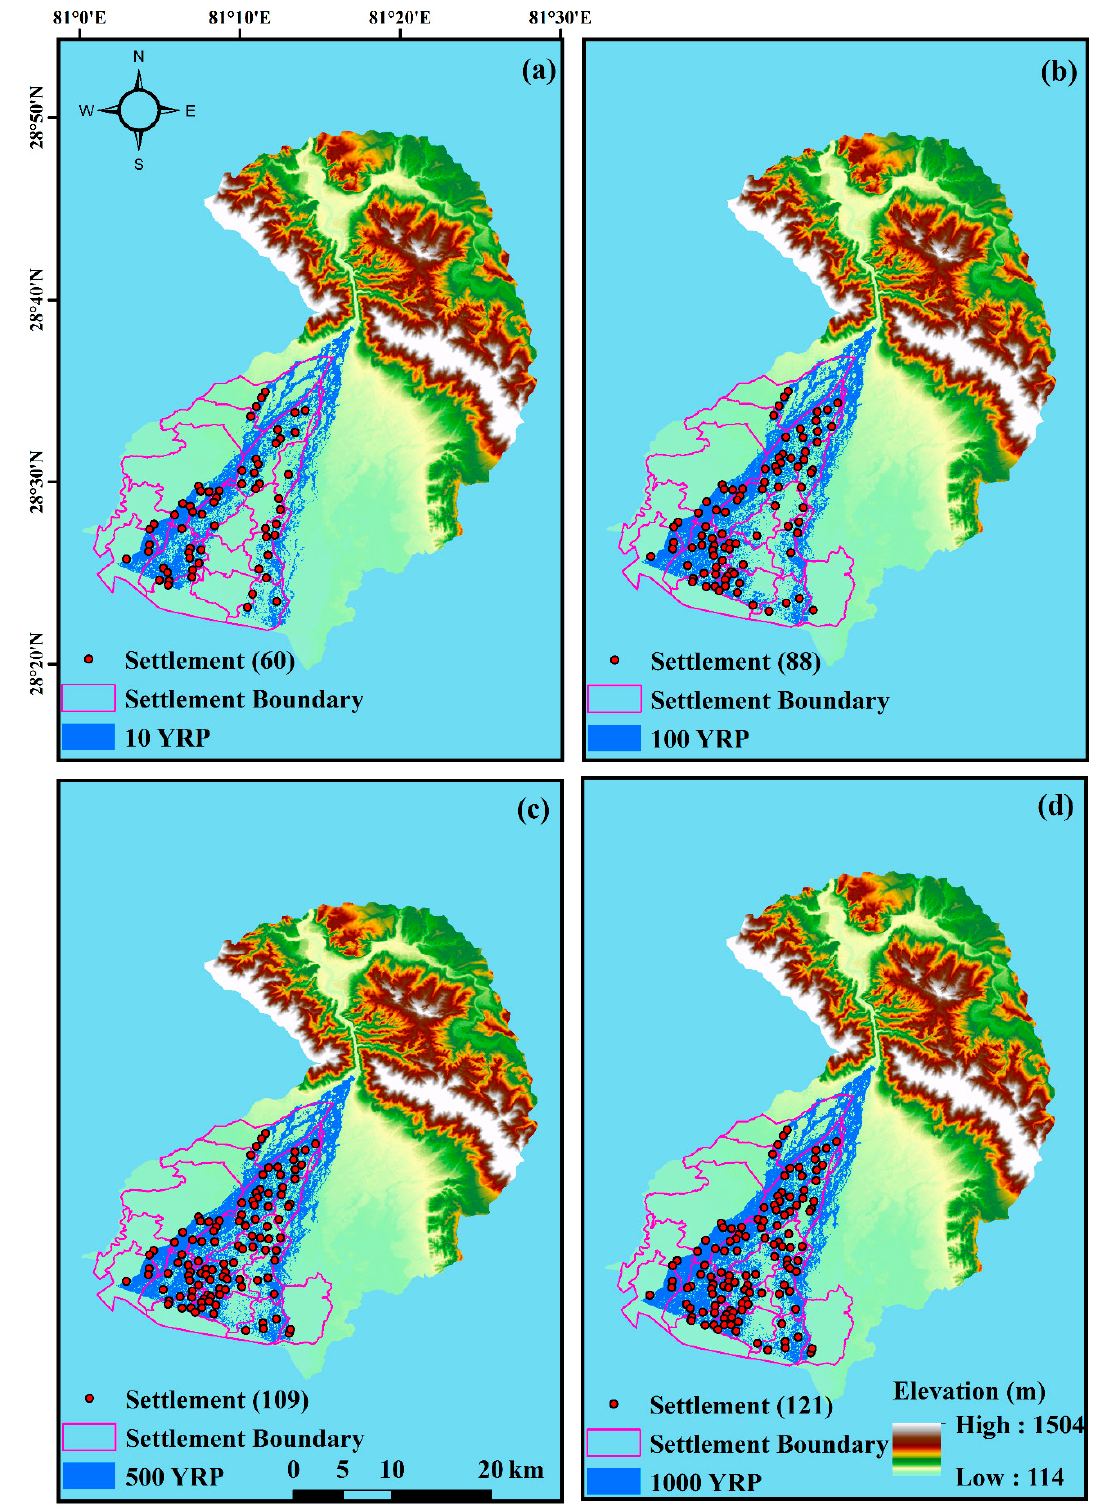
Figure 15. Simulated flood impacts on the number of local settlements given in brackets, with the corresponding boundaries of multiple locations obtained by different YRP floods (( a ) 10 YRP, ( b ) 100 YRP, ( c ) 500 YRP, and ( d ) 1000 YRP).